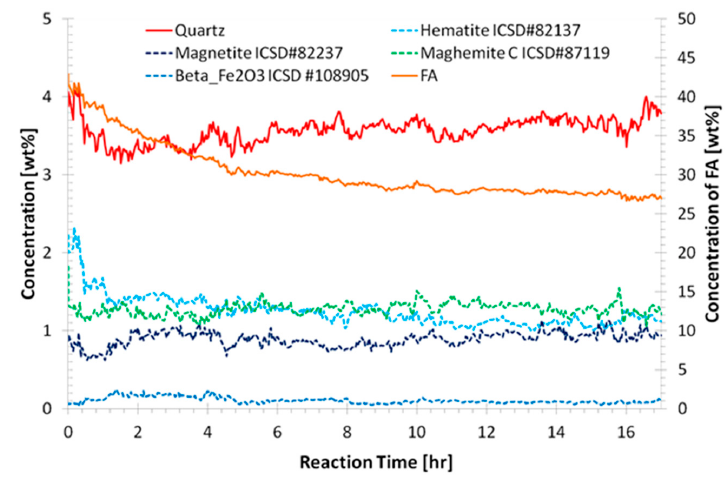
Figure 5. Quantitative phase results from the refinement CFA-2.0-1.2-5.5. The concentration of the flyash (FA) amorphous phase is shown on the right hand side axis. Results from other samples are shown in Supplementary Materials Figure S5. Table 2. Summary of the flyash amorphous phase concentration; initial concentration was calculated from mix formulation and QPA results of the starting flyash [24] and the final concentration was determined by the refinement of the WAXS data. The Compressive Strength (CS) has been shown again for comparison.